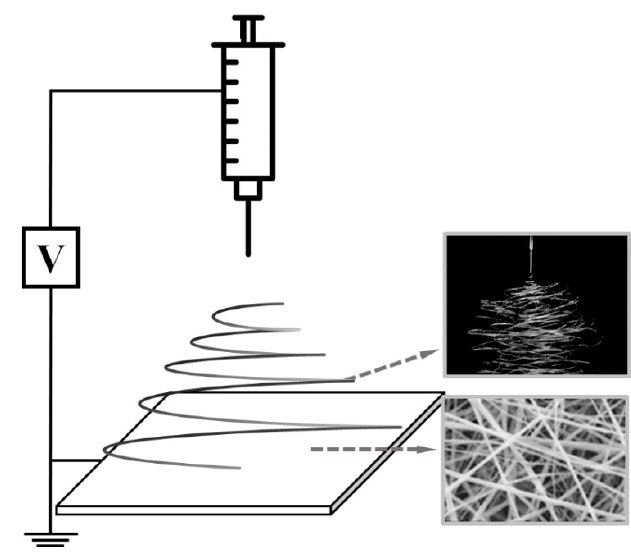
Scheme 3. Electrospinning